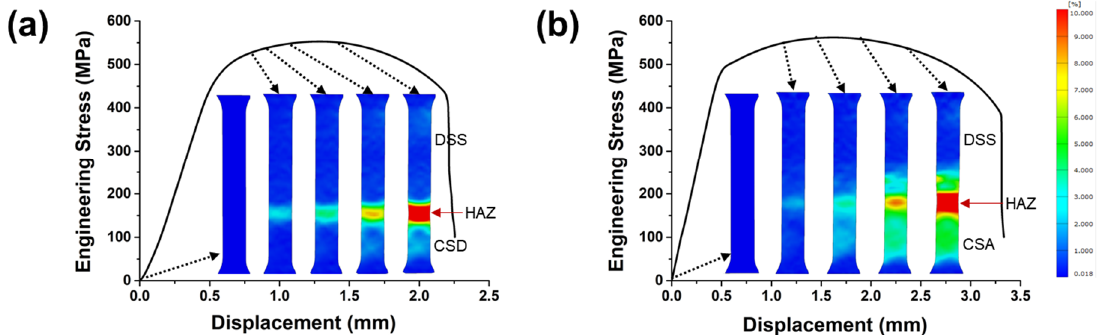
Figure 5. Engineering stress–displacement curves of the WJs with different filler metals: ( a ) DF and ( b ) AF under the HF condition to observe their local strain distribution.